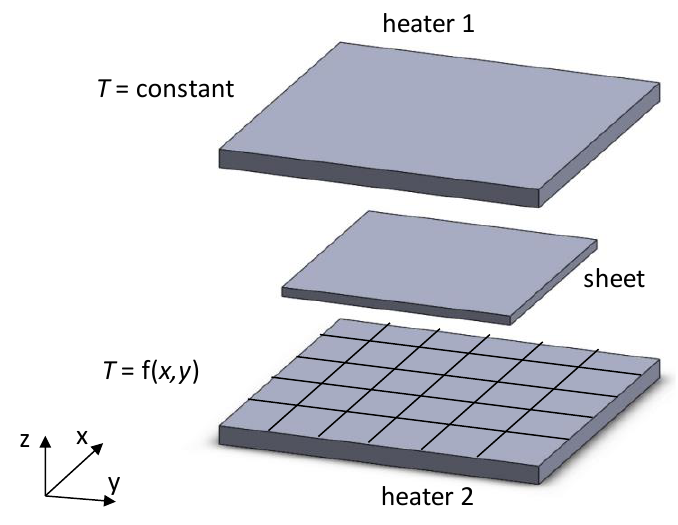
Figure 4. Heating phase: one or two heaters with constant or variable temperature.